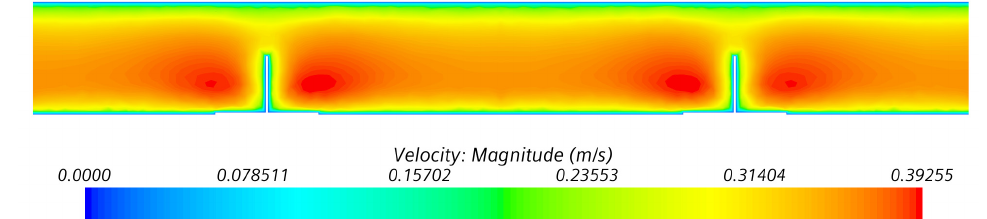
Figure 16. Velocity field—horizontal cross section at height of 10 m winter extreme.